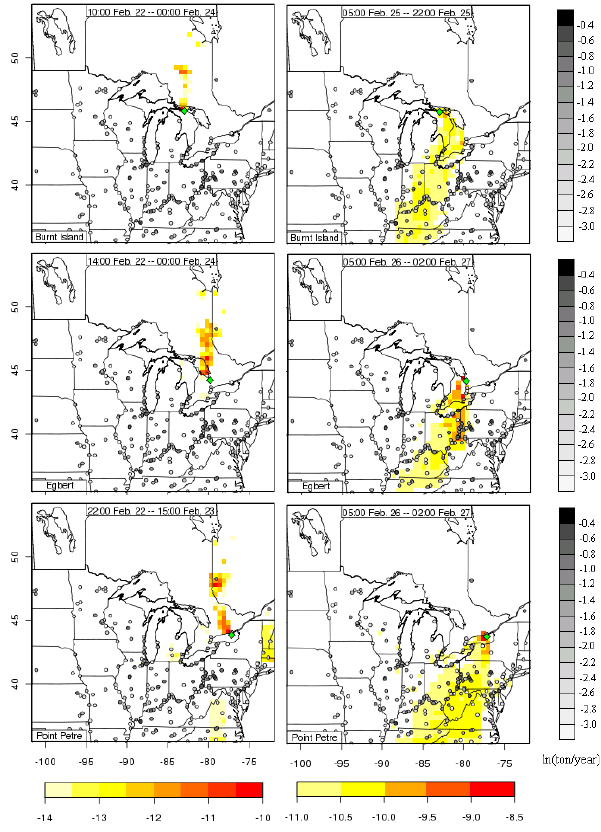
Fig. 7. Source contributions [log 10 (ppm)] derived by multiplying the footprint with gridded emissions for the selected Hg plumes (right) and low episodes (left) in 18–27 February for Burnt Island (top), Egbert (middle) and Point Petre (bottom). Important Hg point sources are designated with circles and the greyscale shadings of the circles represent their emission strengths. Note the different scales between the plumes (right) and low (left)